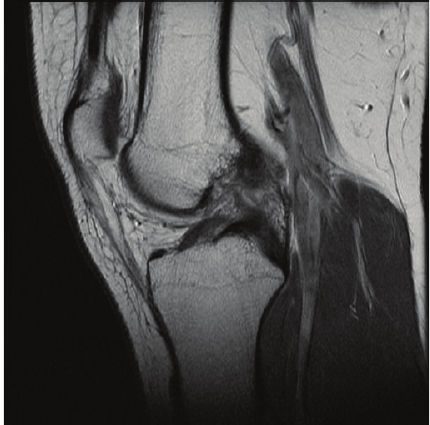
Figure 4: Postoperative sagittal MRI scan of the left knee at 16